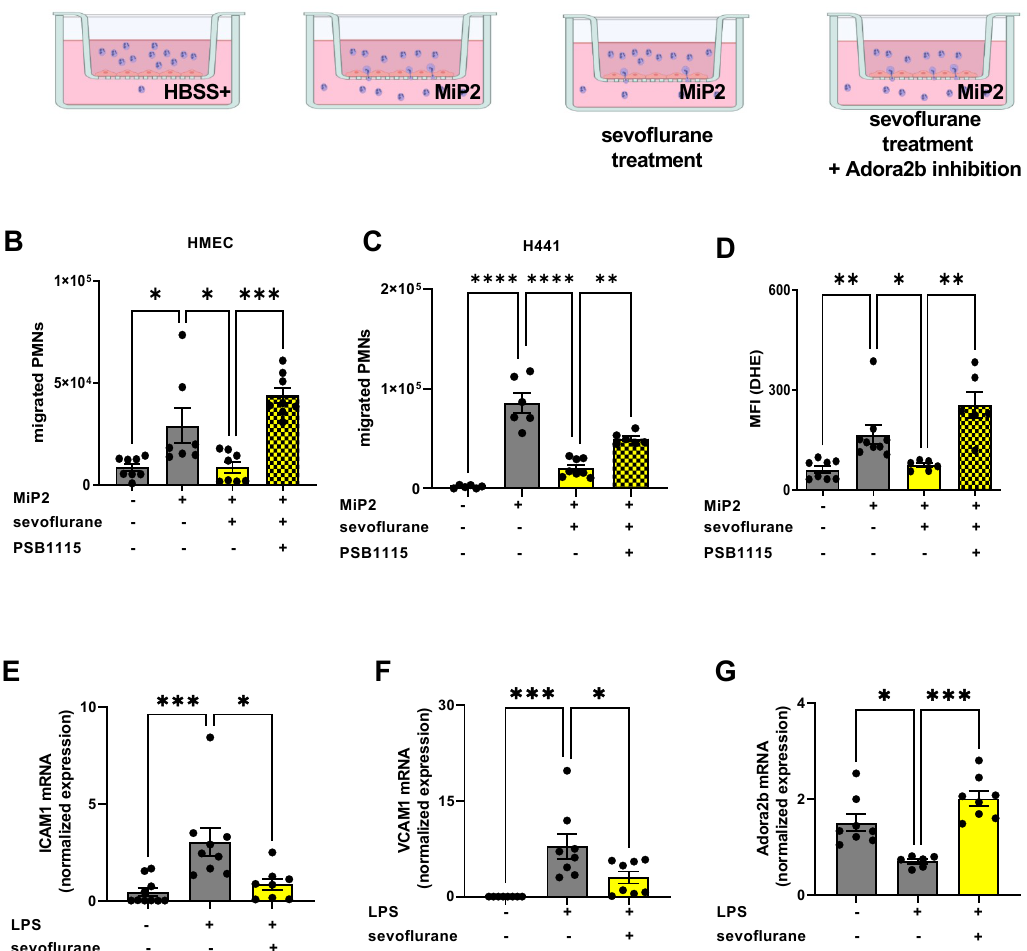
Figure 7. Impact of sevoflurane on the migratory behavior of human polymorphonuclear neutrophils (PMNs) in vitro. ( A ) Model of adhesion and transmigration assay to evaluate the neutrophilic di- apedesis and to determine the impact of sevoflurane on PMN migration. ( B ) Human PMNs from healthy volunteers were isolated and treated by sevoflurane, respectively, sevoflurane and a specific adenosine A2B receptor (Adora2b) antagonist (PSB1115). The migration through a monolayer of human endothelial (HMEC) and ( C ) epithelial monolayer (H441) was initiated by the potent chemoat- tractant macrophage inflammatory protein-2 (MIP-2). ( D ) The impact of sevoflurane on reactive oxygen species activity of human PMNs was assessed by the quantification of dihydroethidium (DHE) activity (mean fluorescence intensity; MFI) ( n = 6–8). ( E ) The gene expression of the human adhesion-related molecules, intercellular adhesion molecule 1 (ICAM1), ( F ) vascular cell adhesion molecule 1 (VCAM1), and ( G ) Adora2b expression were detected by RT-PCR ( n = 6–10). Statistical analyses were one-way ANOVA + Bonferroni correction or Kruskal-Wallis test. Data are presented as mean ± SEM. * p < 0.05; ** p < 0.01; *** p < 0.001, and **** p <